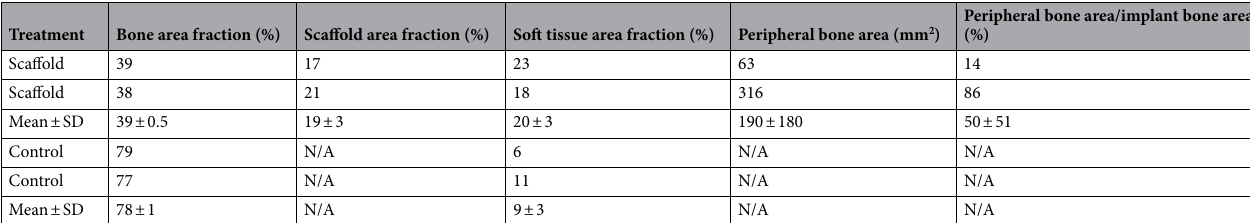
Table 3. Histomorphometry results for the area fraction of each constituent in the scaffold and control treatment groups, and peripheral bone area in the scaffold group. Results from individual specimens are presented, as well as means and standard deviations. The scaffold area fraction and peripheral bone area parameters were not applicable for the control group.